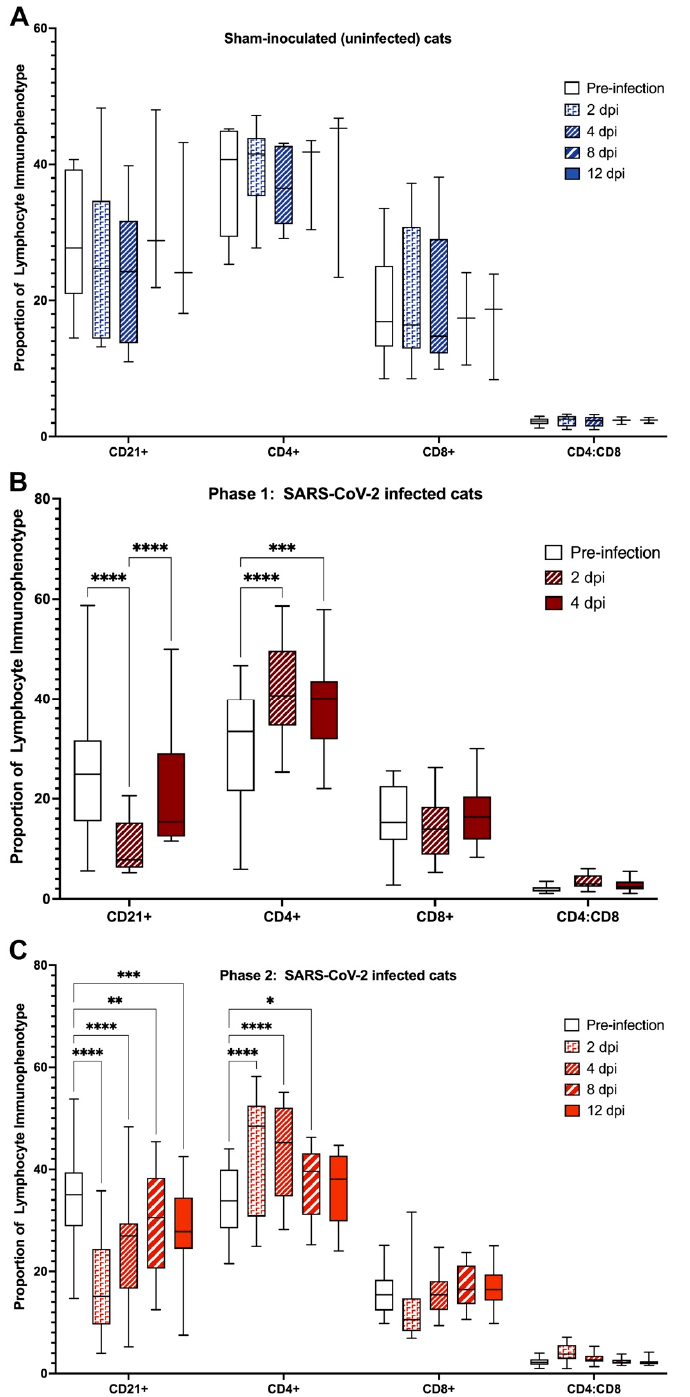
Figure 5. SARS-CoV-2 infected cats exhibit divergent systemic immunophenotypes. ( A ) Sham-inoculated controls do not exhibit any significant differences in lymphocyte immunophenotype throughout the course of the study. ( B ) In contrast, SARS-CoV-2 infected cats in Phase 1 exhibit a significant decrease in the proportion of CD21+ cells at both 2 and 4 dpi. This shift is accompanied by a simultaneous increase in the proportion of CD4+ cells at 2 and 4 dpi. ( C ) Similar to Phase 1, SARS-CoV-2 infected cats exhibit different shifts in systemic lymphocyte immunophenotypes, characterized by a significant decrease in CD21+ cells at 2, 4, 8, and 12 dpi with a concurrent increase in CD4+ cells at 2, 4, and 8 dpi. Repeated measures ANOVA with multiple comparisons (Tukey); * p < 0.05, ** p < 0.01, *** p < 0.001, **** p <